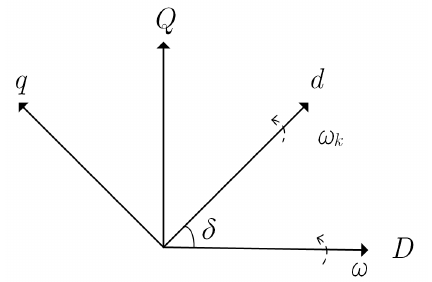
Figure 3. Relationship between the reference frame